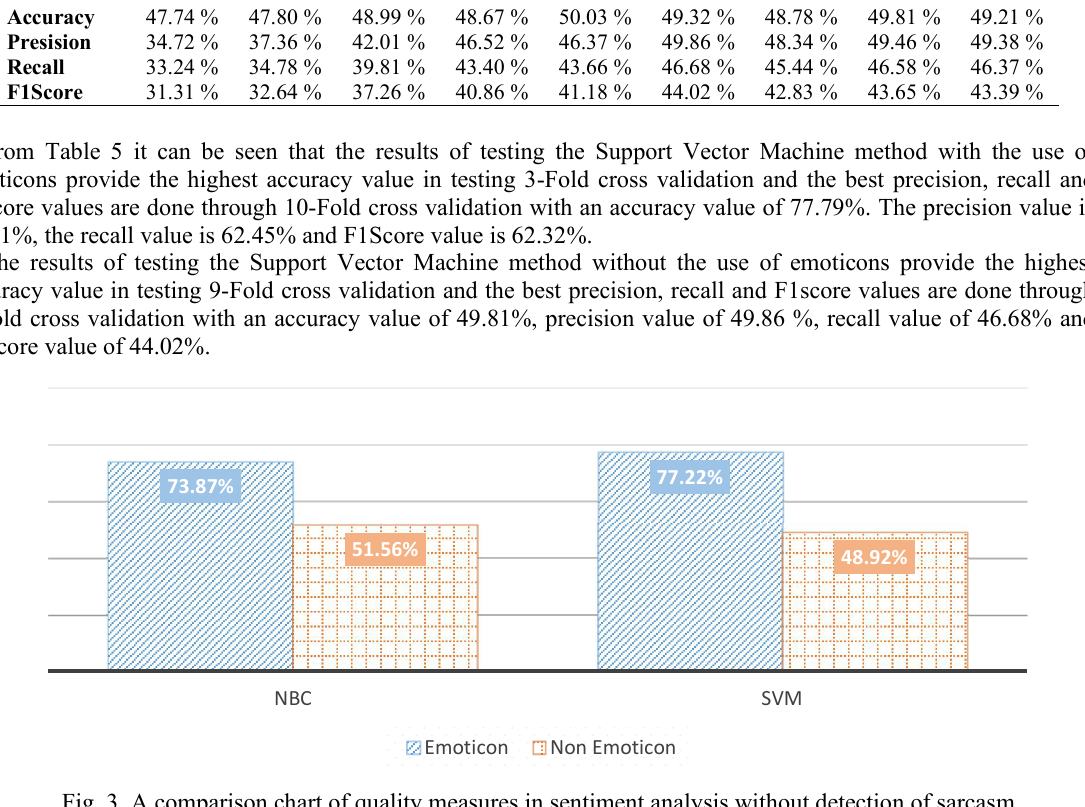
Fig. 3. A comparison chart of quality measures in sentiment analysis without detection of